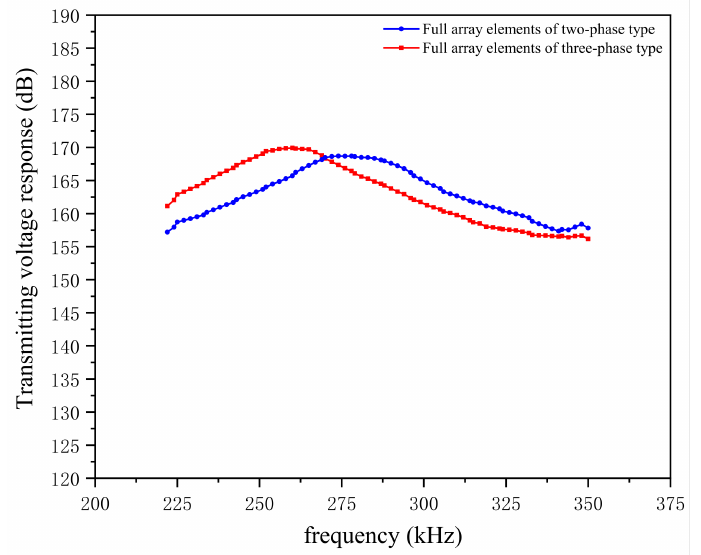
Figure 5. Transmitting voltage response simulation curves of all elements in two types of 1–3 piezoelectric composite